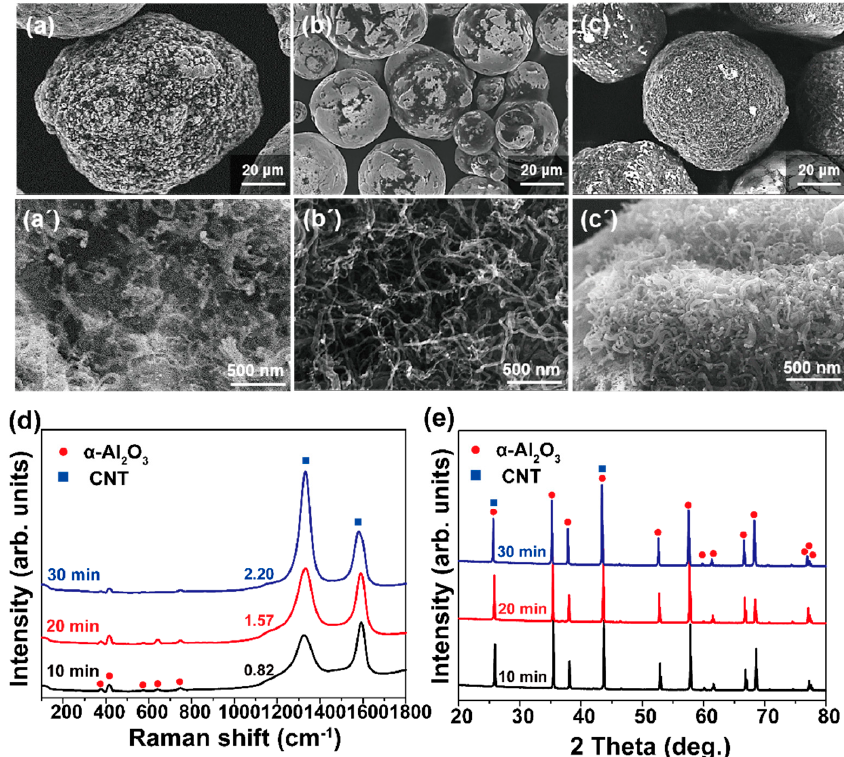
Figure 5. Low ‐ and high ‐ magnification SEM images showing CNTs directly grown on Al 2 O 3 parti ‐ Figure 5. Low- and high-magnification SEM images showing CNTs directly grown on Al 2 O 3 particles cles at 650 °C with 10 rpm of RCVD chamber. Growth time is ( a ) and ( a’ ) 10, ( b ) and ( b’ ) 20, ( c ) and at 650 ◦ C with 10 rpm of RCVD chamber. Growth time is ( a , a’ ) 10, ( b , b’ ) 20, ( c , c’ ) 30 min. ( d ) Raman ( c’ ) 30 min. ( d ) Raman spectra and ( e ) XRD profiles obtained from ( a ) to ( c ) samples. spectra and ( e ) XRD profiles obtained from ( a – c )